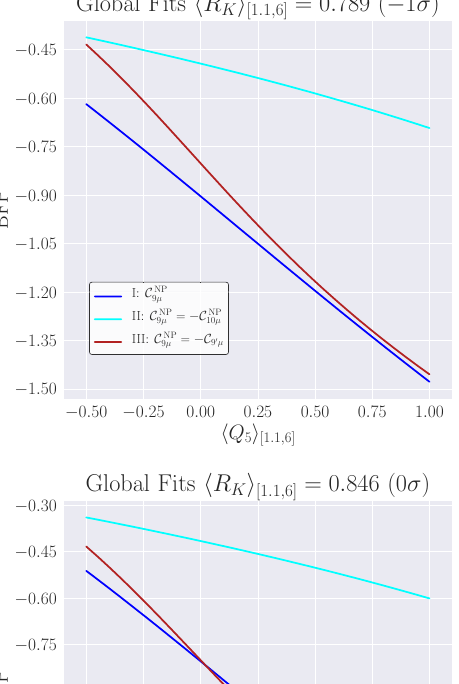
on the b.f.p.s of the NP hypotheses under consideration Q 5 (cid:31) (cid:30) [1 . 1 , 6] R K (cid:30) [1 . 1 , 6] (cid:31)